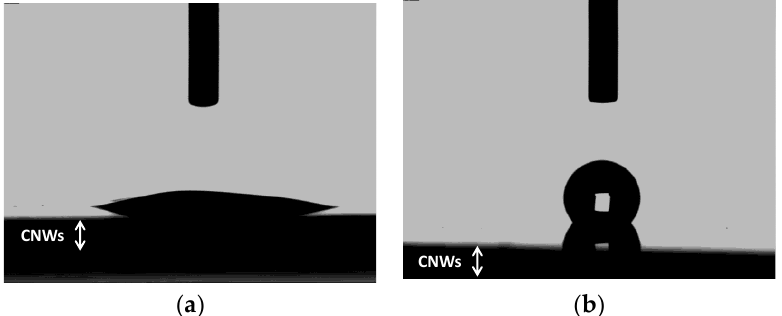
Figure 5. Contact angle images for droplets of water on the CNWs/Si substrate, ( a ) without or ( b ) with atmospheric pressure plasma treatment of the CNWs.